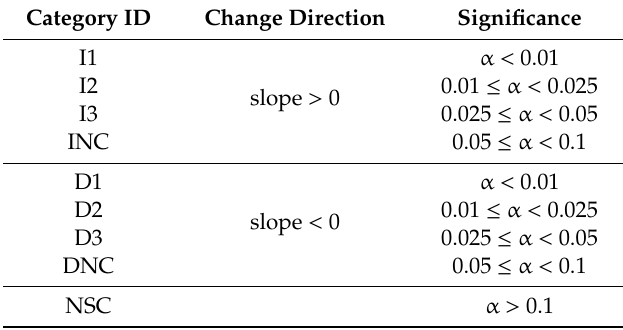
Table 1. Category threshold for vegetation change.